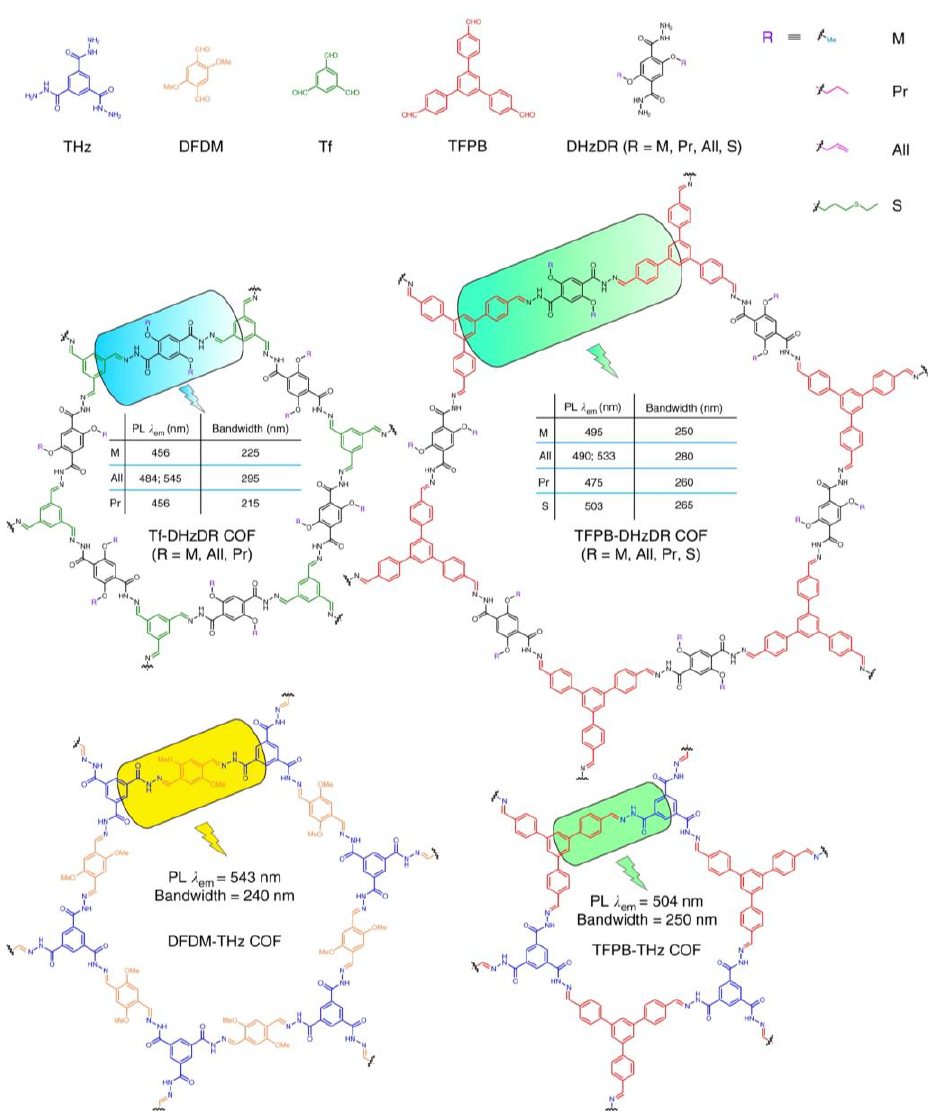
Figure 4. Synthetic scheme for accessing the emissive COFs based on acylhydrazone bond. The pho- toluminescent emission maxima and bandwidths are shown for each COF from Ref. [52]. Reprinted with permission from Ref. [52]. Copyright 2018, Nature Publishing Group.